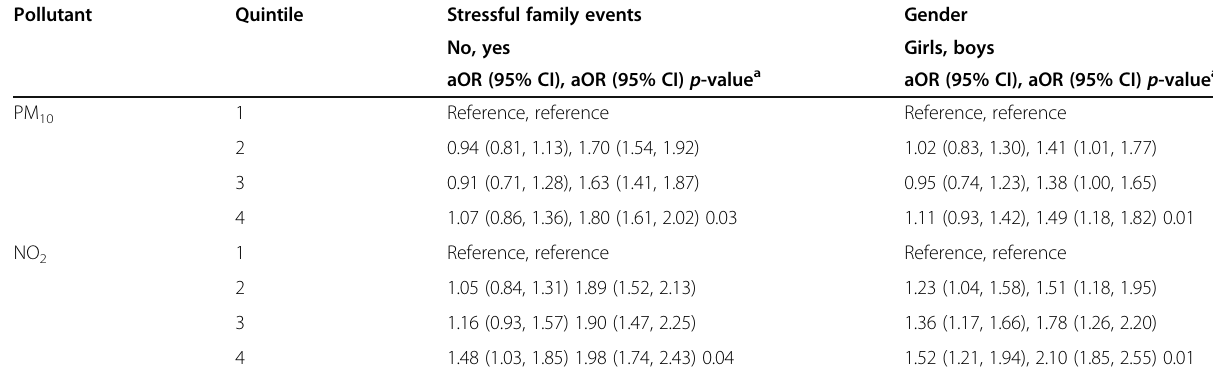
Table 7 Conditional logistic regression estimated adjusted odds ratios (aORs) and 95% confidence intervals (CIs) for associations of allergic rhinitis with air pollutant concentrations, stratified by stress and gender Pollutant